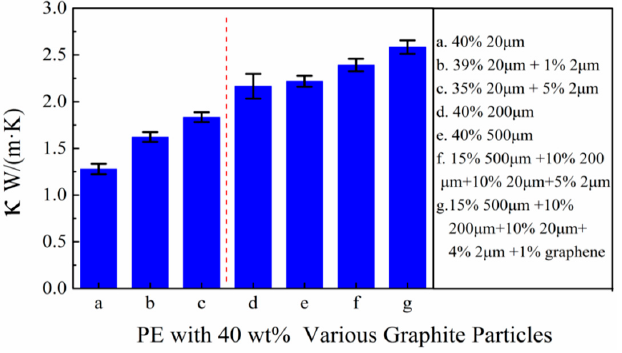
Figure 5. Thermal conductivities of HDPE with 40 wt % various filling particles (the size unit is μ m).